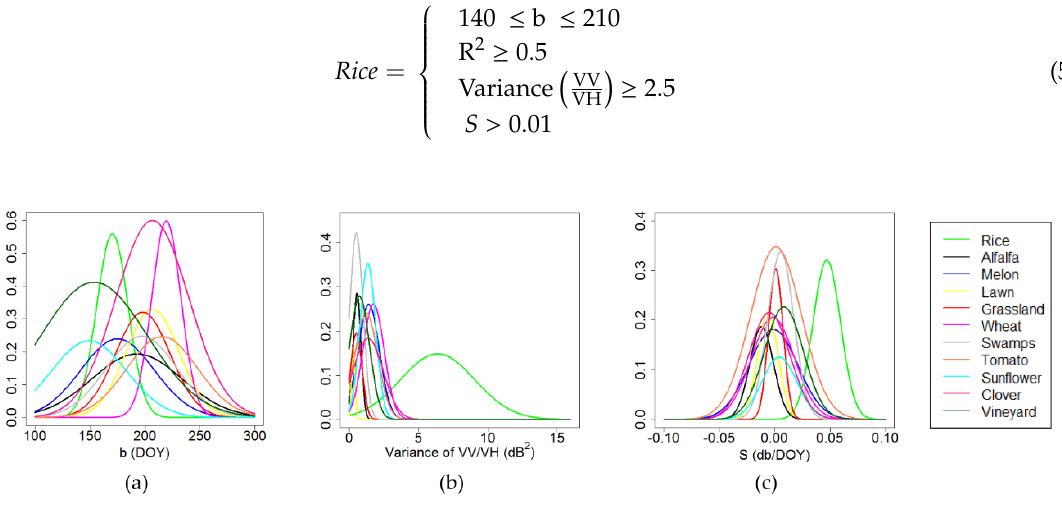
Figure 7. Distribution of the ( a ) position of the maximum of the VV / VH Gaussian fitting; ( b ) variance of the VV / VH time series; and ( c ) slope of the VH linear fitting for 11 crop types represented by the normal distribution function.